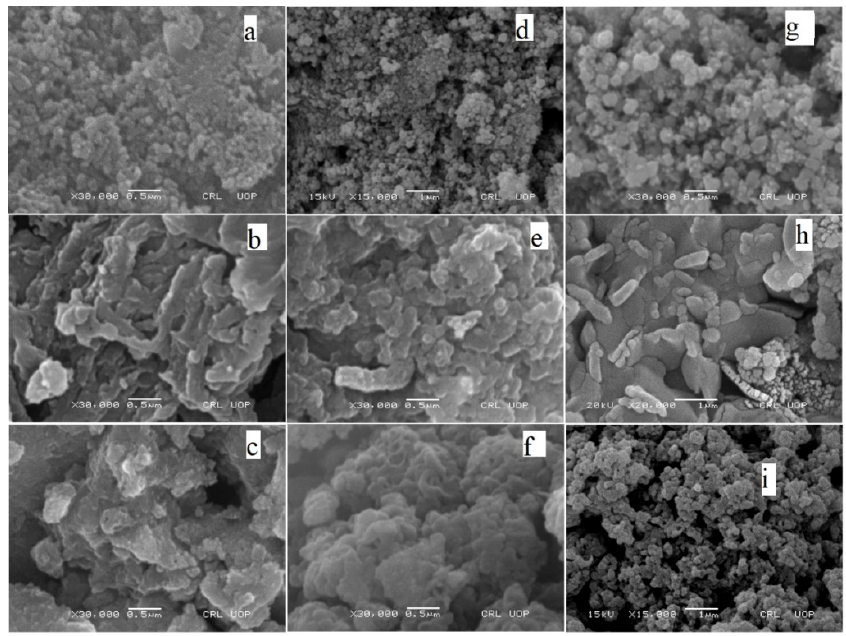
Figure 1. SEM images of Fe 3 O 4 , PANI (polyaniline). and PANI/Fe 3 O 4 composites ( a – c ) before adsorption, ( d – f ) after Cr(VI) adsorption, and ( g – i ) after Ni(II)